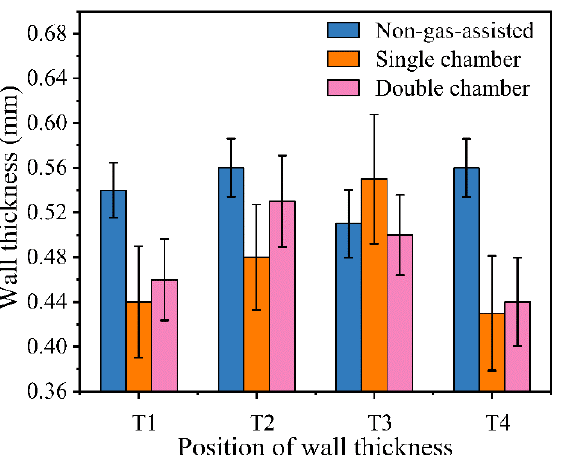
Figure 12. Wall thickness distribution of plastic micro-tubes for gas inlet volume flow rate of 6 × 10 −5 m 3 /s. Table 2. Experimental conditions.